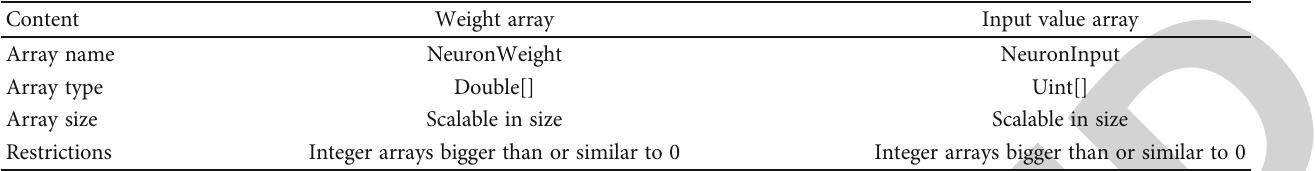
Table 2: Description table of arti fi cial neuron class